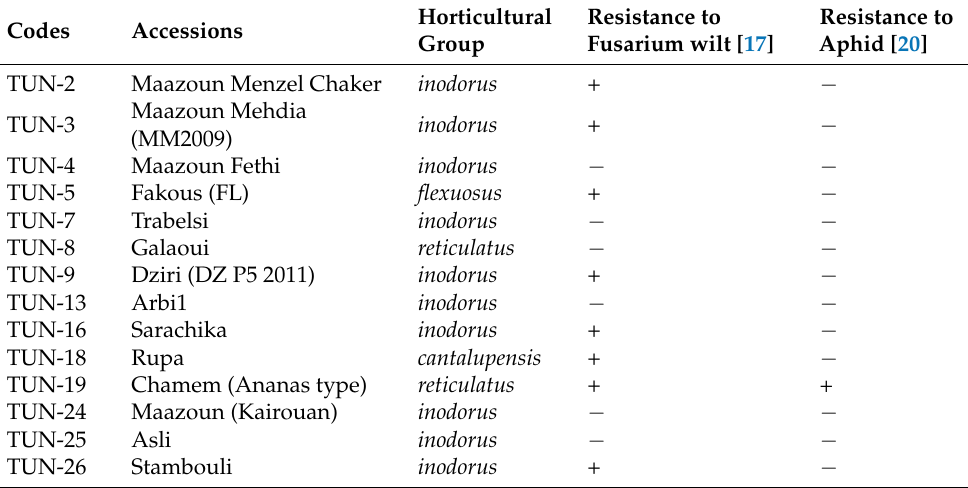
Table 1. Tunisian melon landraces used and their main characteristics regarding some biotic stress